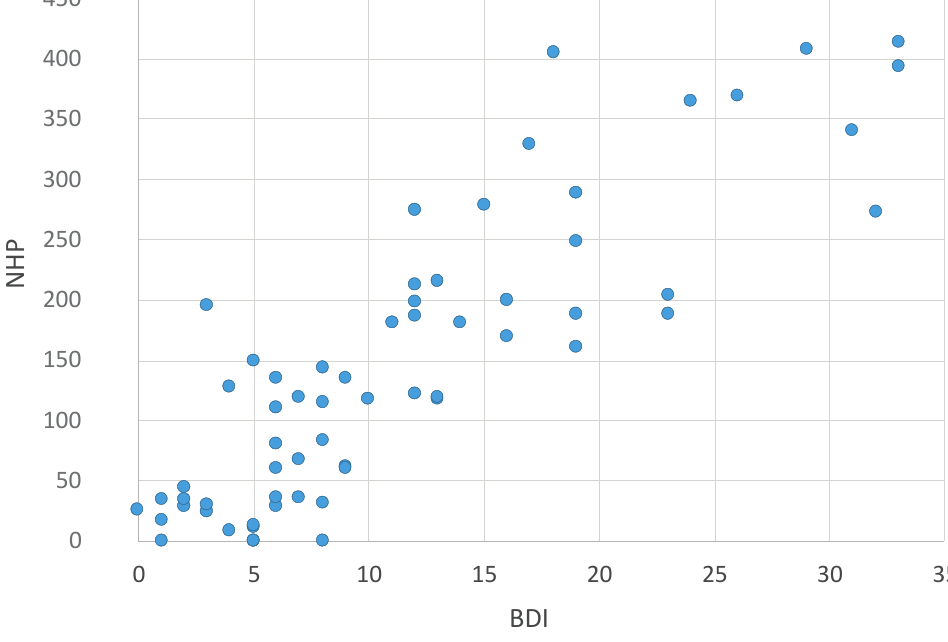
Figure 4. Correlation between NHP and BDI values. Abbreviations: NHP = Nottingham Health Profile; BDI = Beck Depression Inventory